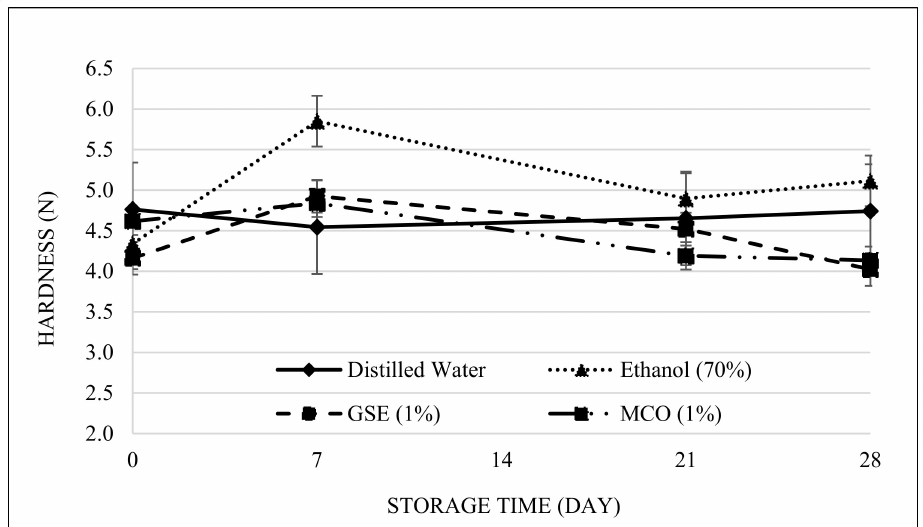
Figure 1. Changes in hardness (N) of rice cakes that were treated with distilled water, ethanol (70%), GSE (1%), or MCO (1%) ( p <